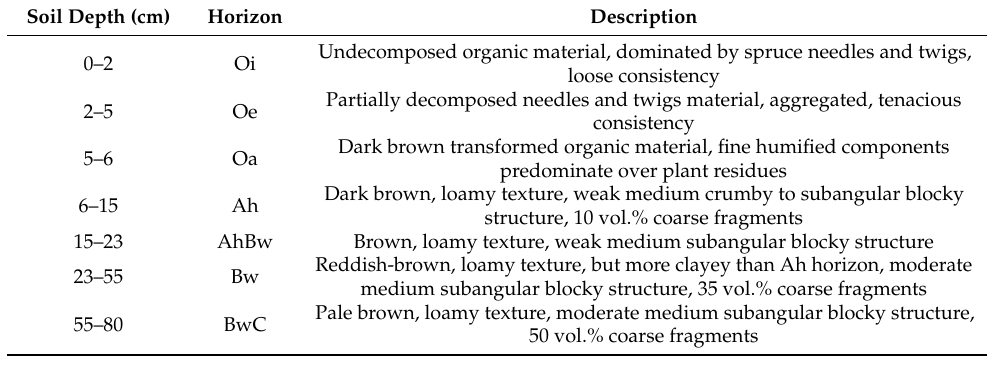
Table 1. Morphology of the opened forest soil profile.